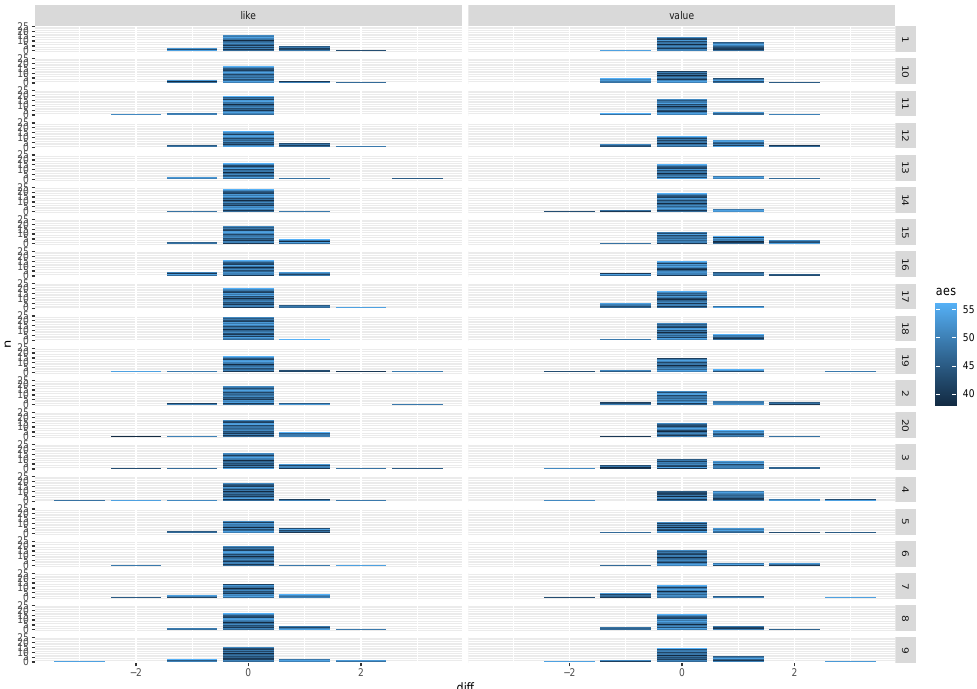
Figure 4. Score (preference and value) differences before and after information is